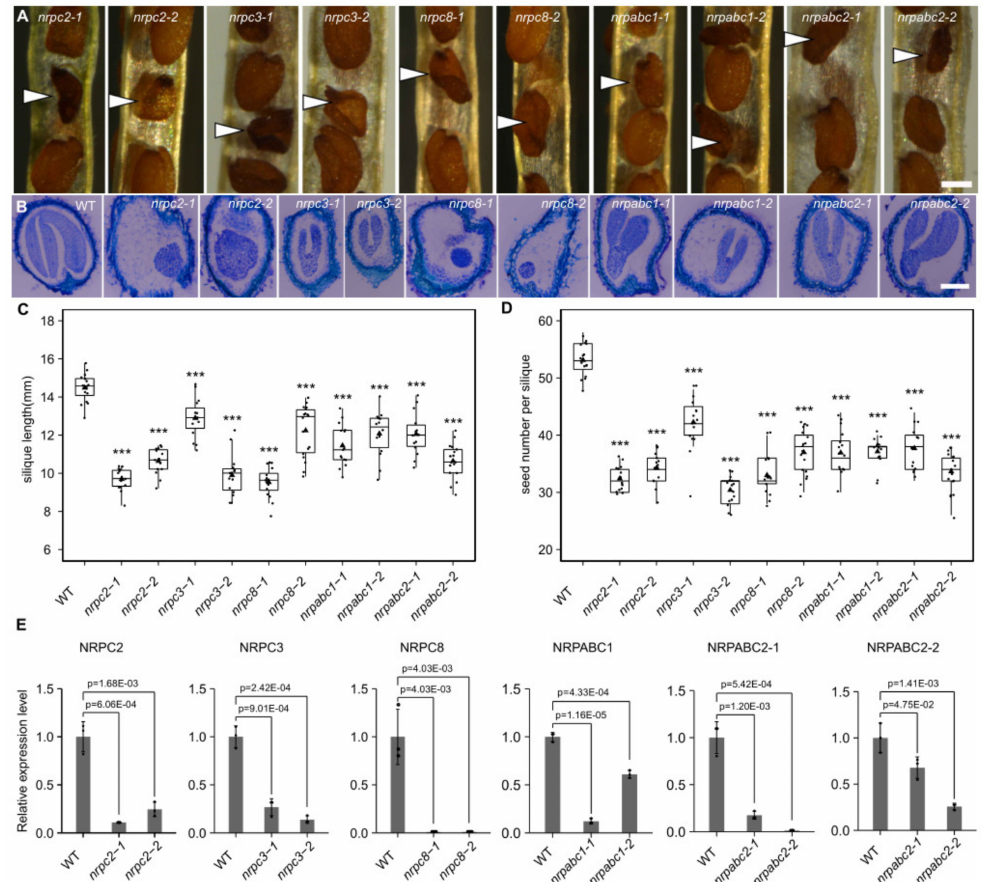
Figure 2. Phenotypic features of seeds with knockdown of different subunits genes, and analysis of the expression of different subunits in seeds of wild-type and different subunit knockdown lines. ( A ) Phenotypic features of mature seeds (white arrows indicate mutant seeds). Scale bar = 300 µ m. ( B ) Longitudinal paraffin sections of developing seeds at 15DAF. Scale bar = 100 µ m. ( C ) Average silique length at 10 DAF. Asterisks indicate significant difference by Student’s t -test (“***” p < 0.001). ( D ) Seed number per silique. Asterisks indicate significant difference by Student’s t -test (“***” p < 0.001). ( E ) RT-qPCR analysis of different subunits-encoding genes in seeds at 10 DAF of wild-type and different RNAPIII subunit knockdown lines. All expression levels are normalized to that of ACTIN . Three replicates for each sample were performed, and data are means ± SD. p -values determined by Student’s t